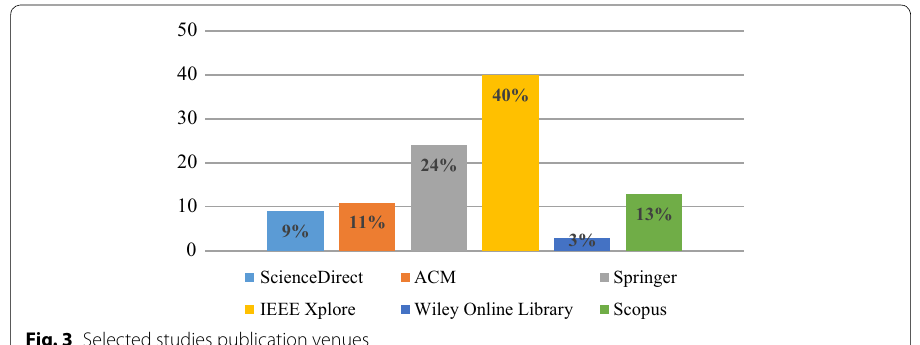
Fig. 3 Selected studies publication venues